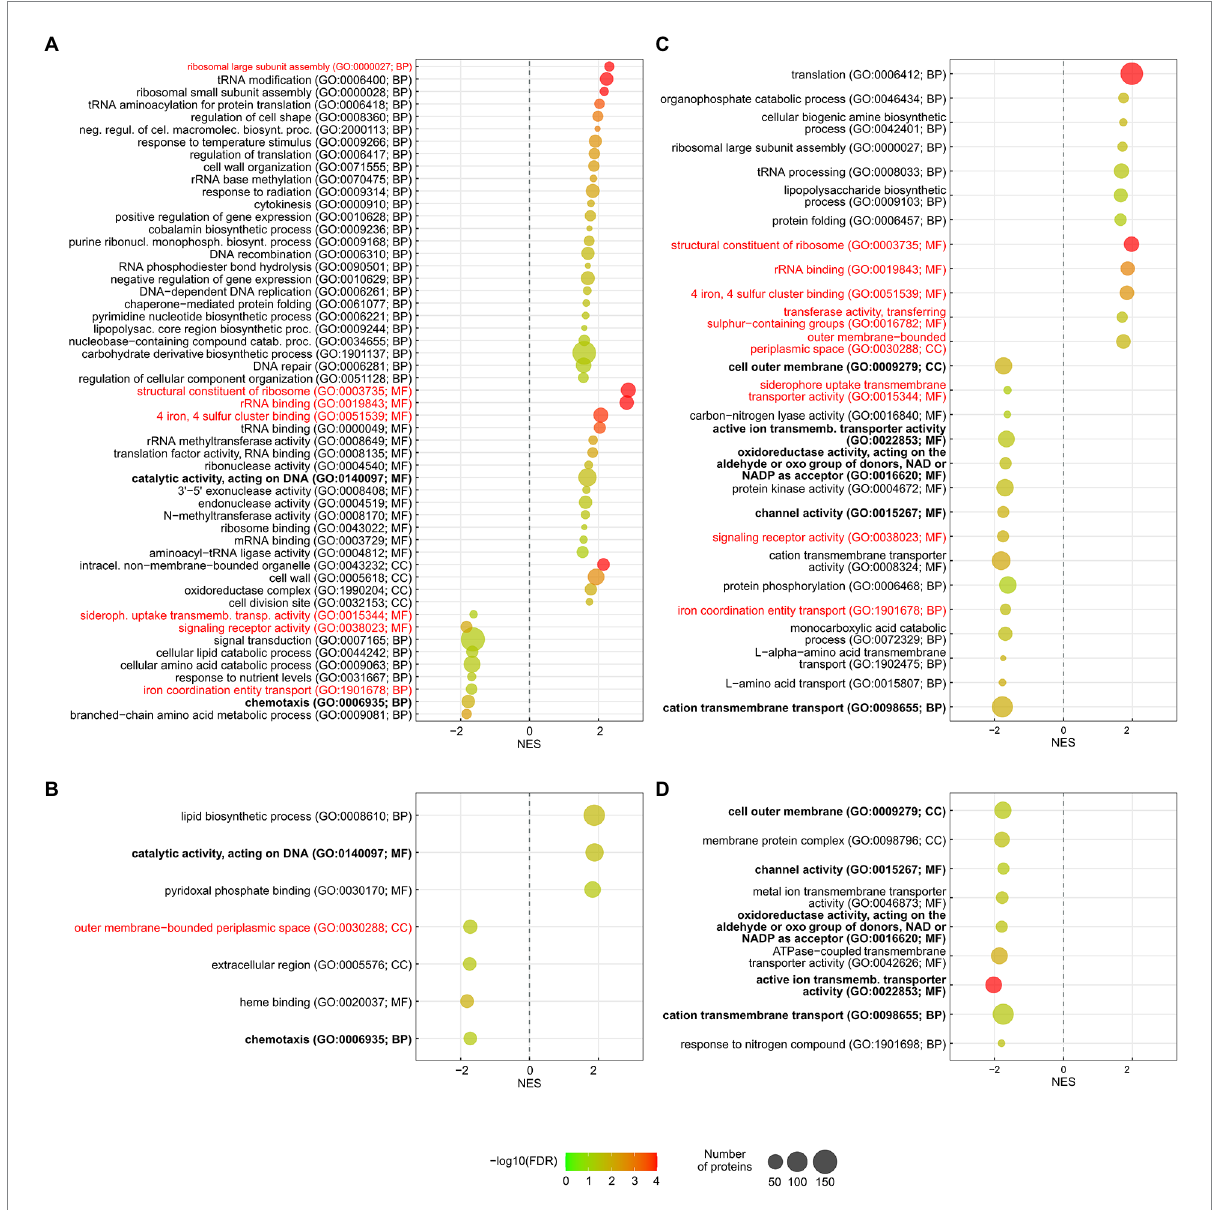
FIGURE 5 GO terms that were significantly enriched when the strains were cultivated with the two highest sub-MICs of meropenem. Pseudomonas aeruginosa CCUG 51971 was cultivated with 256 μ g/ml (A) and 128 μ g/ml (B) . P. aeruginosa CCUG 70744 was cultivated with 8 μ g/ml (C) and 4 μ g/ml (D) . In red: GO terms enriched in both strains. In bold: GO terms enriched in both conditions of one strain. BP, biological process; MF, molecular function; CC, cellular component; FDR, false discovery rate; NES, normalized enrichment